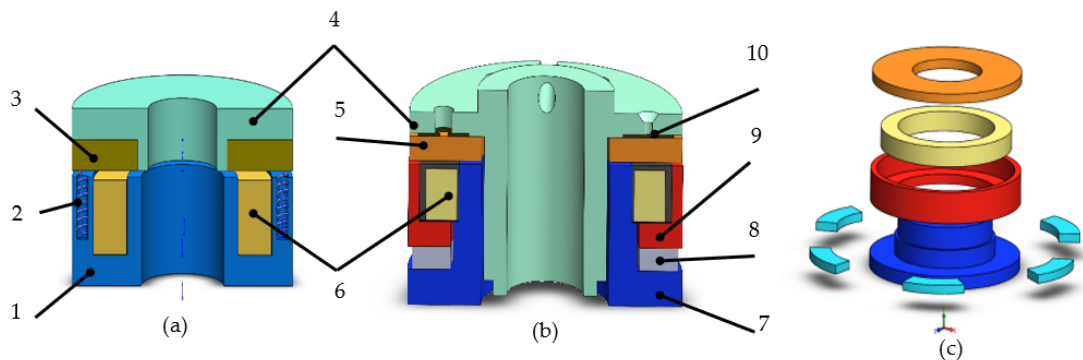
Figure 1. Structure of brakes. ( a ) Non-excited brake. ( b ) High-torque permanent magnet brake. ( c ) Three-dimensional explosion diagram of a permanent magnet brake. 1. Yoke iron. 2. Spring. 3. Fric- tion plate. 4. Flange. 5. Disc armature. 6. Coil. 7. Inner yoke iron. 8. Permanent magnet. 9. Outer yoke iron. 10. Plate spring.